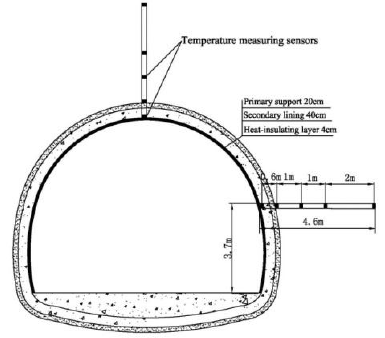
Figure 6. Layout of measuring holes and temperature sensors in the field test of the Dege tunnel.